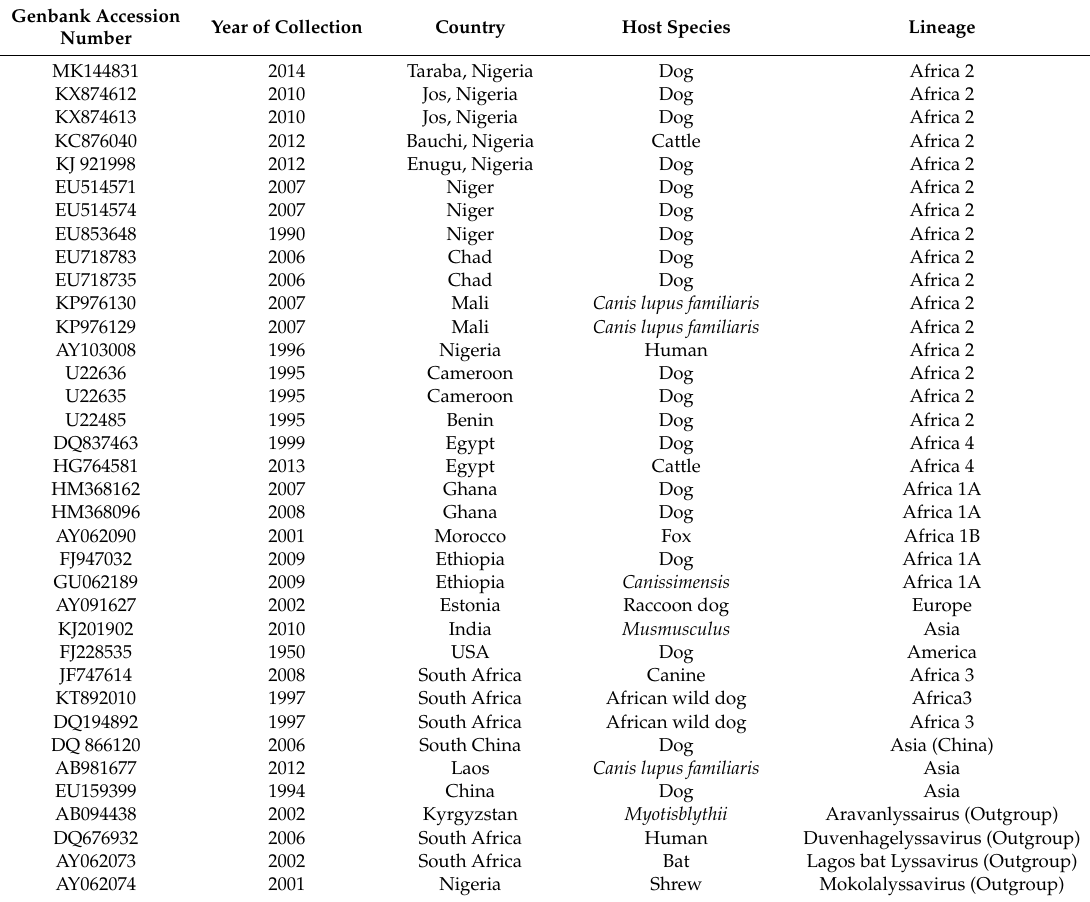
Table 2. Rabies diagnostic samples collected from Genbank for molecular and phylogenetic